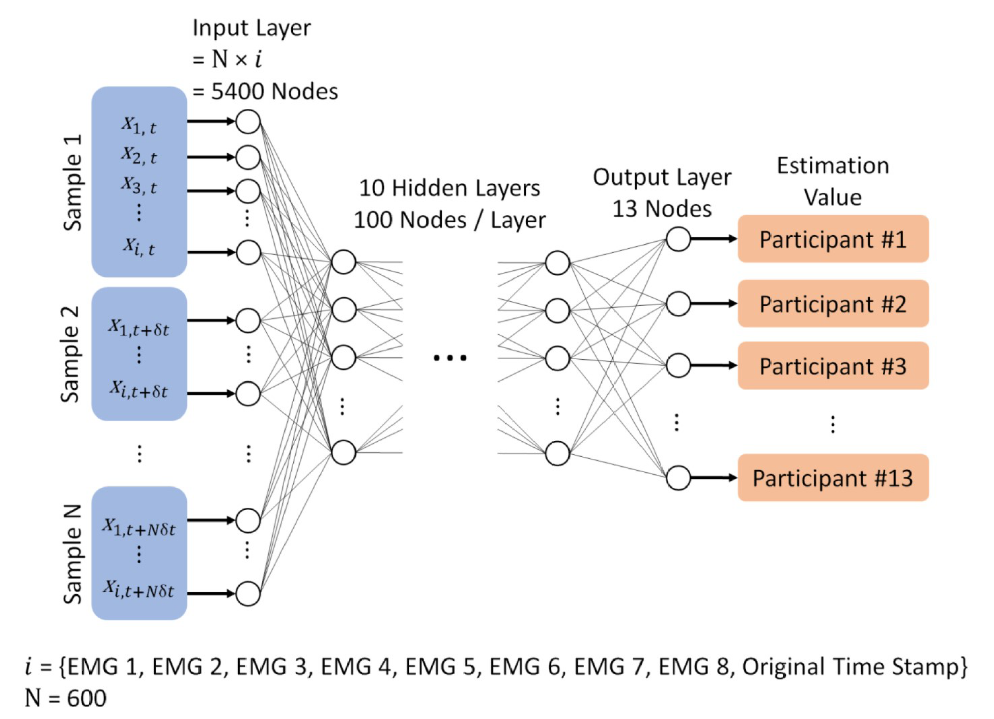
Figure 6. The computational